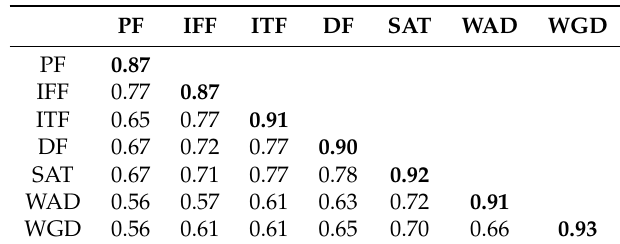
Table 3. Inter-construct